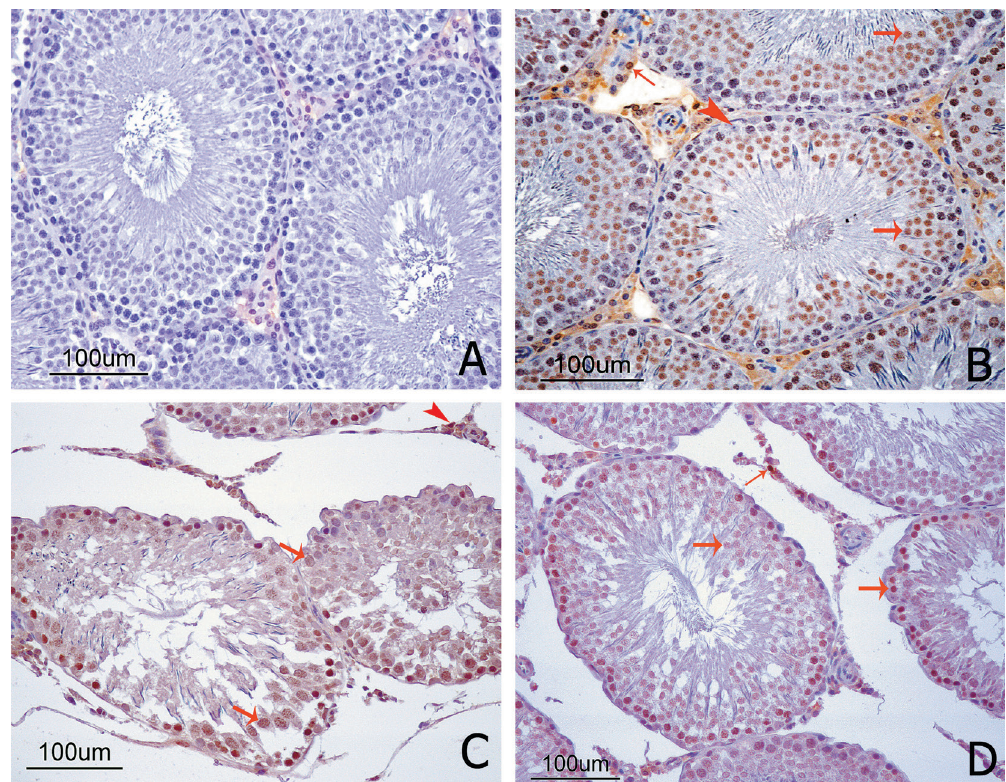
FIGURE 2 - GPx1 immunolocalization in cross-sections of the rat testes. (A) The negative control showed no GPx1 staining. (B) The control group showed strong nuclear expression of GPx1 in the germ (thick arrows) and Leydig cells (thin arrow). No staining was observed in the Sertoli cells (arrowhead). (C) The MTX group showed weak nuclear GPx1 immunoreactivity in the germ (arrows) and Leydig cells (arrowhead). (D) The MTX + SMN group showed intense nuclear GPx1 immunoreactivity in the germ (thick arrows) and Leydig (thin arrow)